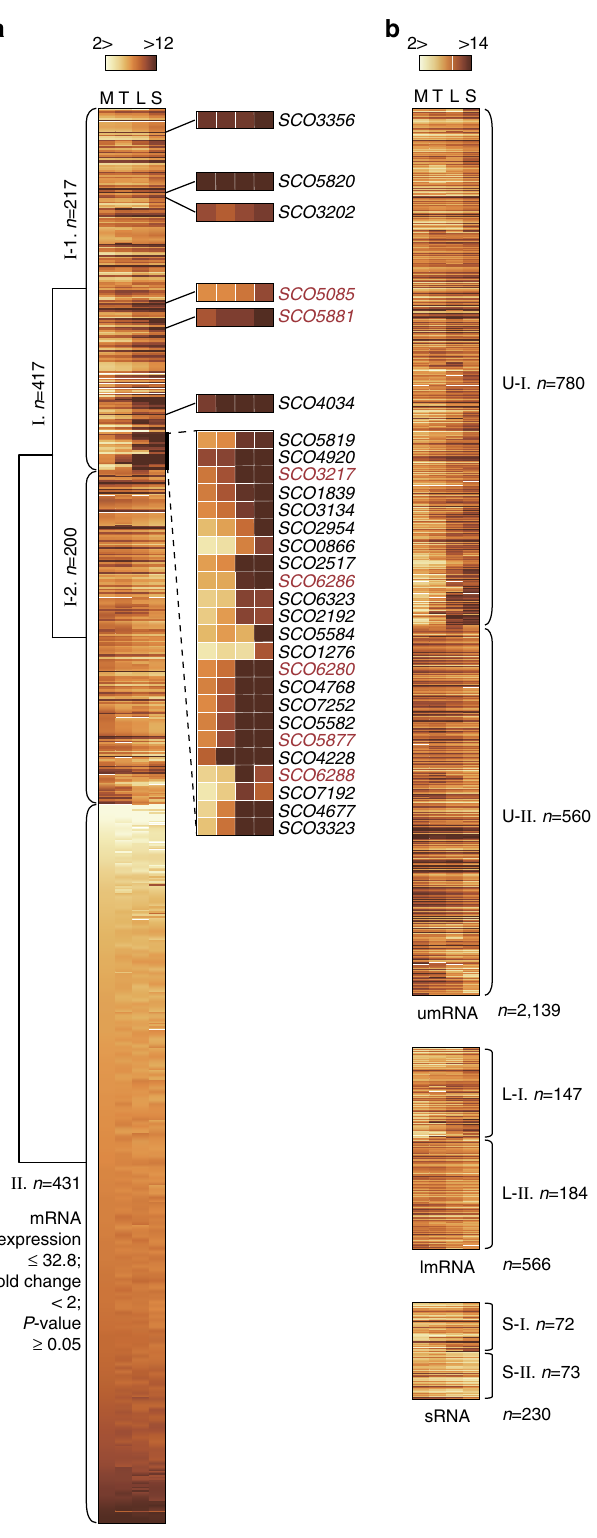
Figure 3 | Transcriptome dynamics at different growth phases. ( a ) All transcriptional regulatory genes are clustered by their expression patterns where almost half of the regulatory genes are differentially expressed at different growth phases ( I ), whereas the other half showed no changes, or expression levels lower than the cutoff ( II ). Bold black letters indicate sigma factors, and bold red letters indicate regulators of secondary metabolic gene clusters. ( b ) Differential expression of umRNAs, lmRNAs and sRNAs at different growth phases. Clusters are labelled U-I, U-II, L-I, L-II, S-I and S-II and the genes comprising each cluster are listed in Supplementary Data 6. M, mid-exponential phase; T, transition phase; L, late exponential phase; S, stationary